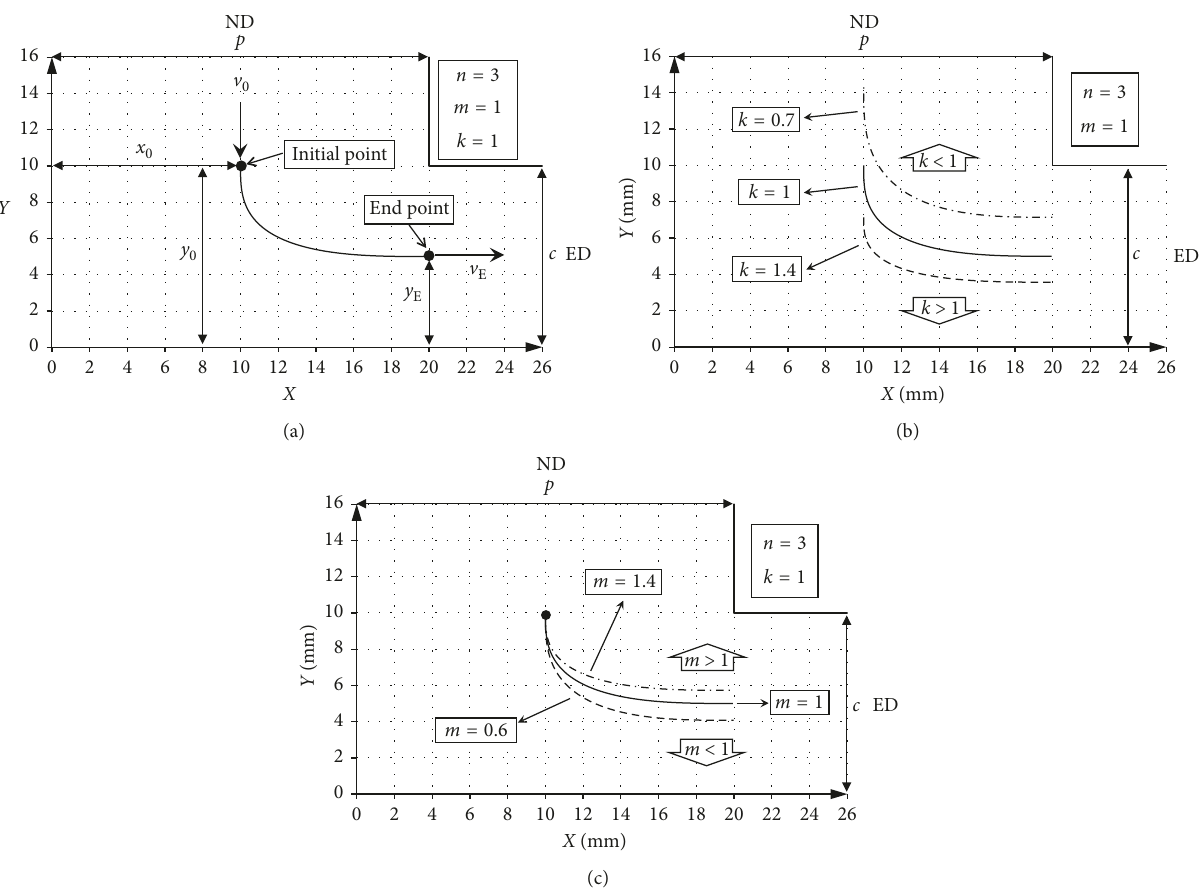
Figure 1: (a) Geometry for positioning the initial and end points of the flow lines in an NECAP die. The effect of the (b) k parameter on the shape of the flow line that enters at x 0